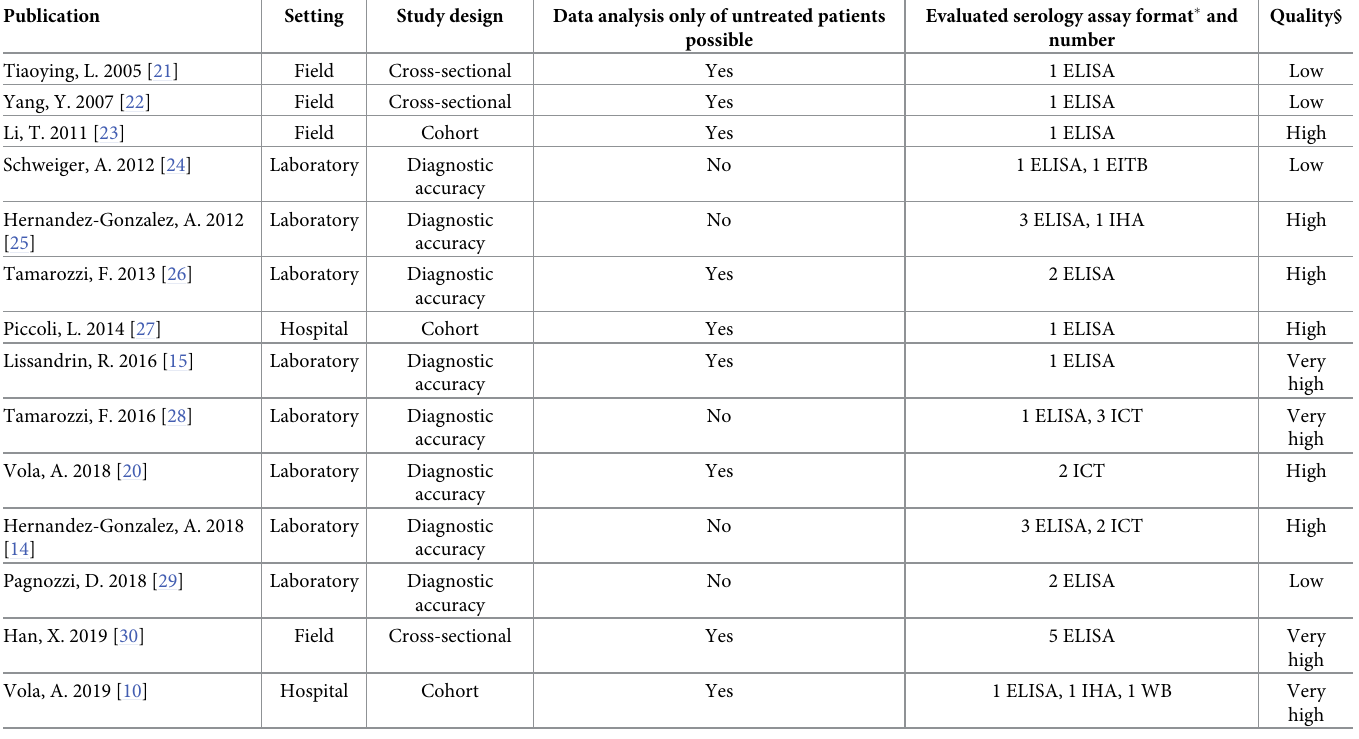
Table 1. Main characteristics of the papers included in the